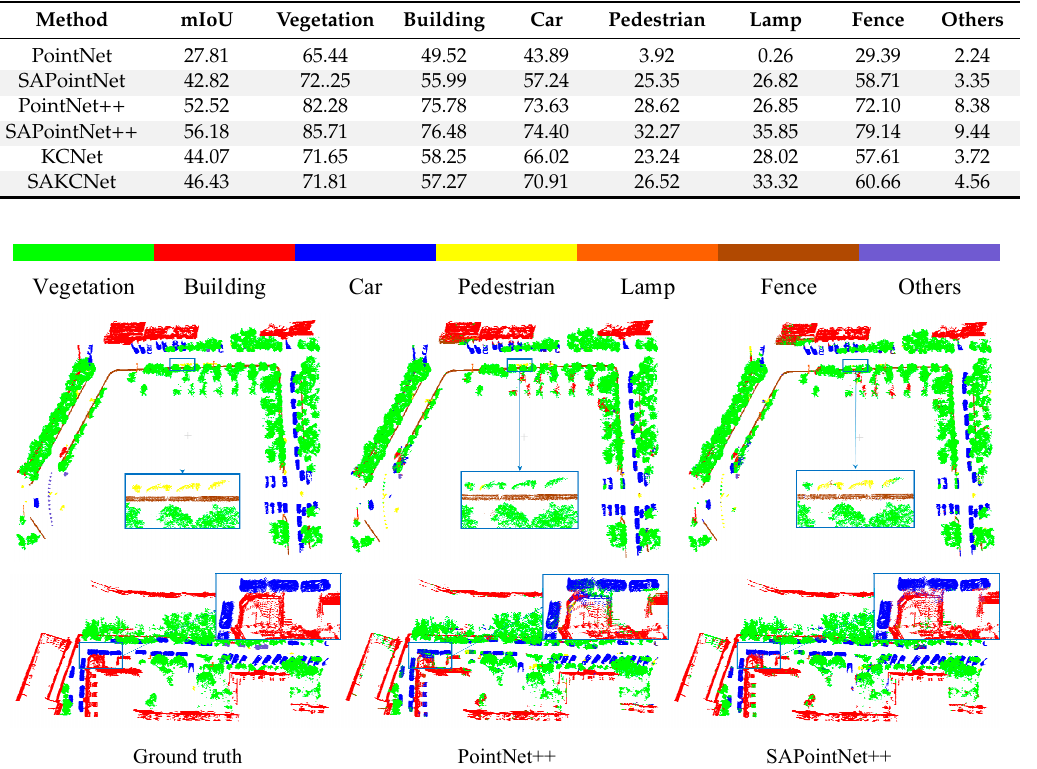
Figure 8. Semantic segmentation results on the WHU MLS point clouds.